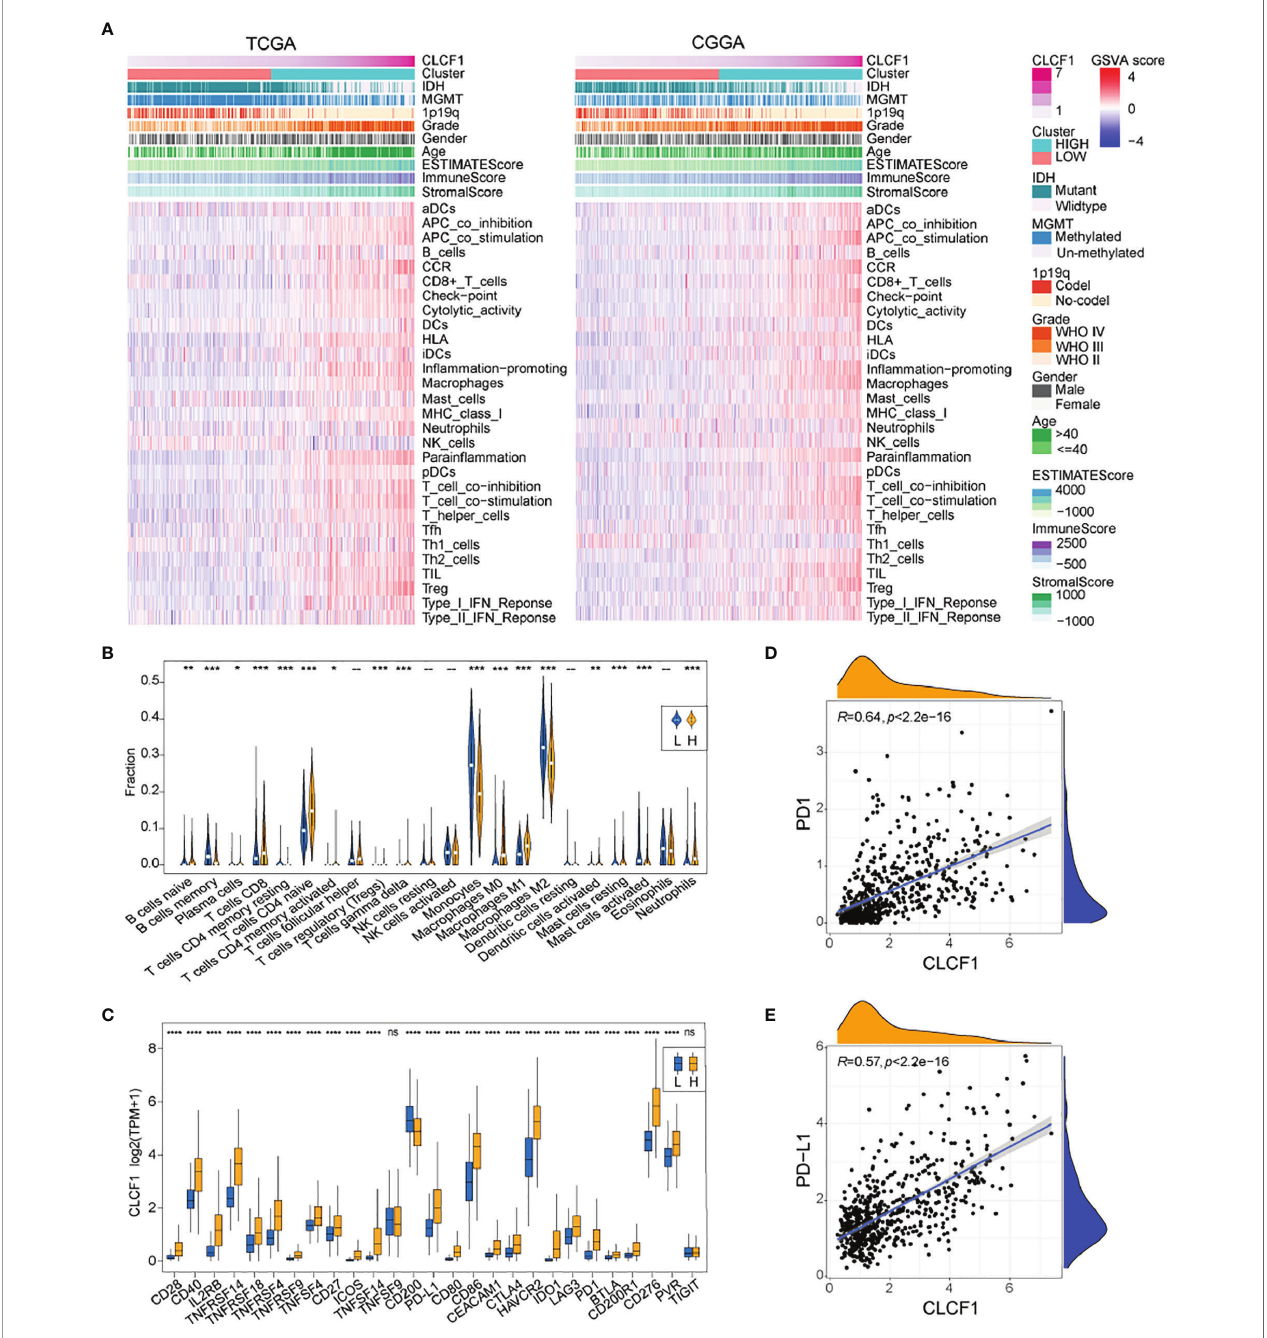
FIGURE 6 | (A) The heatmap for enrichment scores based on “ immune signatures ” in TCGA and CGGA; (B) Comparison of TIICs between the low and high CLCF1 expression groups in TCGA; (C) The difference of ICPs expression between subgroups in TCGA; The correlation between expression of CLCF1 and (D) PD1, (E) PD-L1 and in TCGA cohort; Signi fi cance: ns P > 0.05, *P < 0.05, **P < 0.01, ***P < 0.001, ****P <